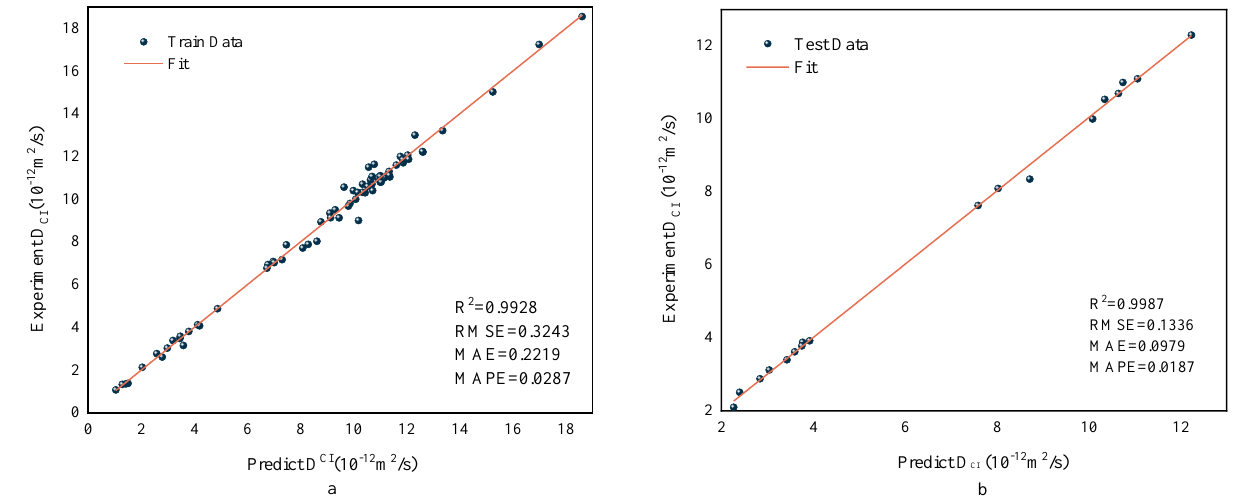
Figure 15. Regression results for the Training ( a ) and Testing ( b ) sets of the MWOA-ELM model.